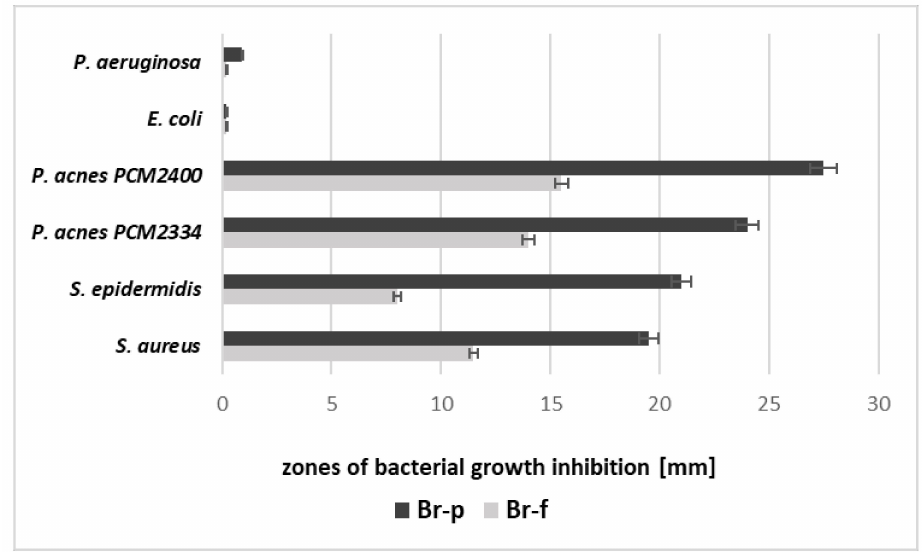
Figure 1. Zones of bacterial growth inhibition as antibacterial activity of Burdock